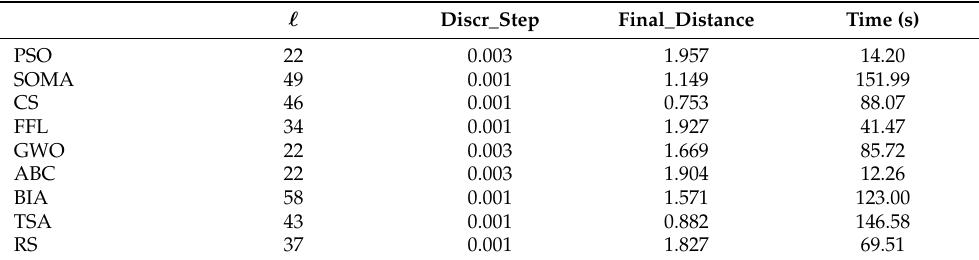
Figure 8. Checkpoints of each algorithm automatic parameter tuning with maxFES = 10,000. Red lines are values of final _ distance and blue ones show the maximum value of Manhattan distance. Grey dashed lines show values thresholds. Table 8. The best results of evolutionary algorithms with a value of maxFES =